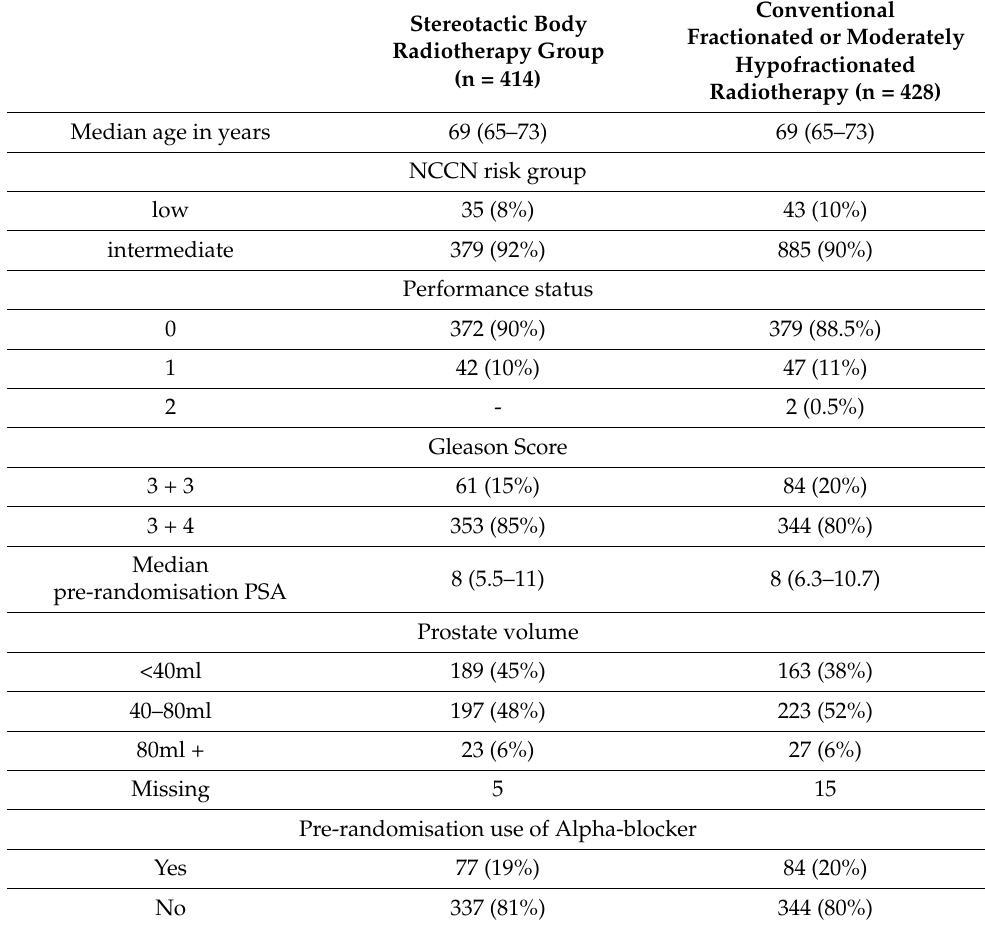
Table 1. Baseline demographics and clinical